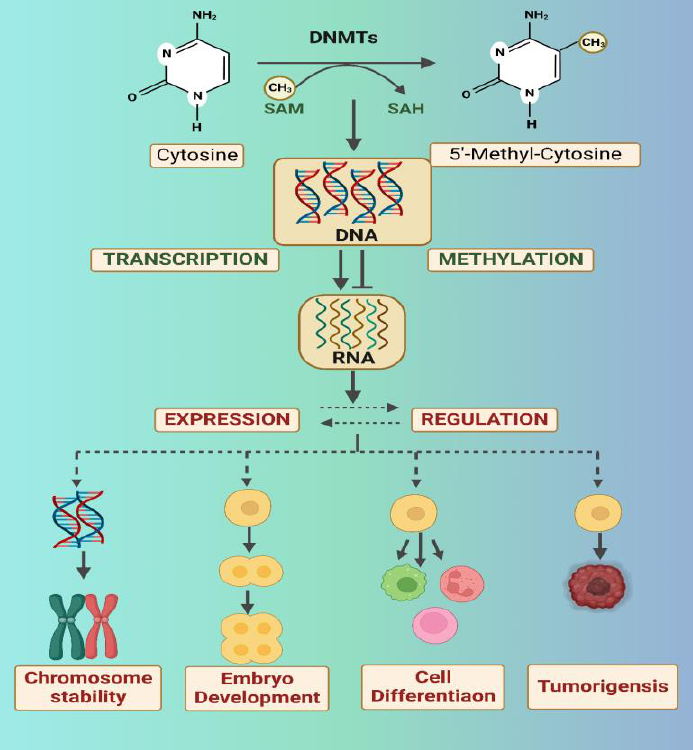
Figure 1. The properties of DNMTs in mammalian cells. (Concept taken from [40] and created